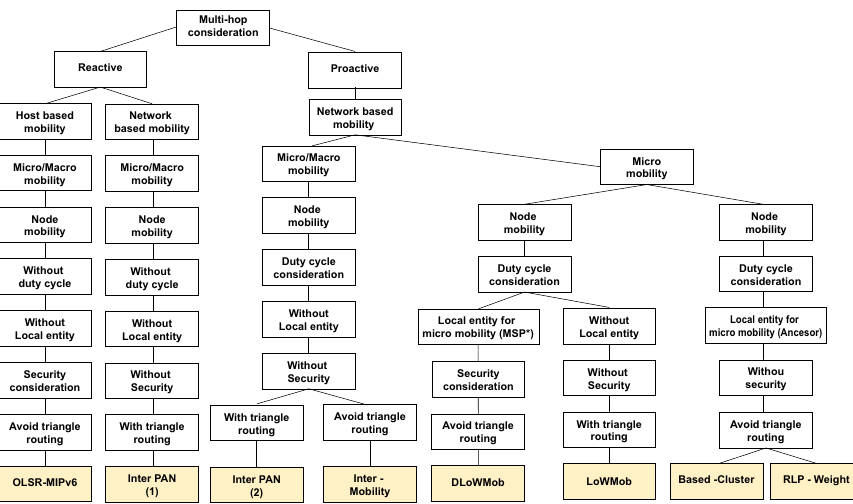
Figure 7. WSN protocols based on 6LoWPAN with multi-hop support [30].